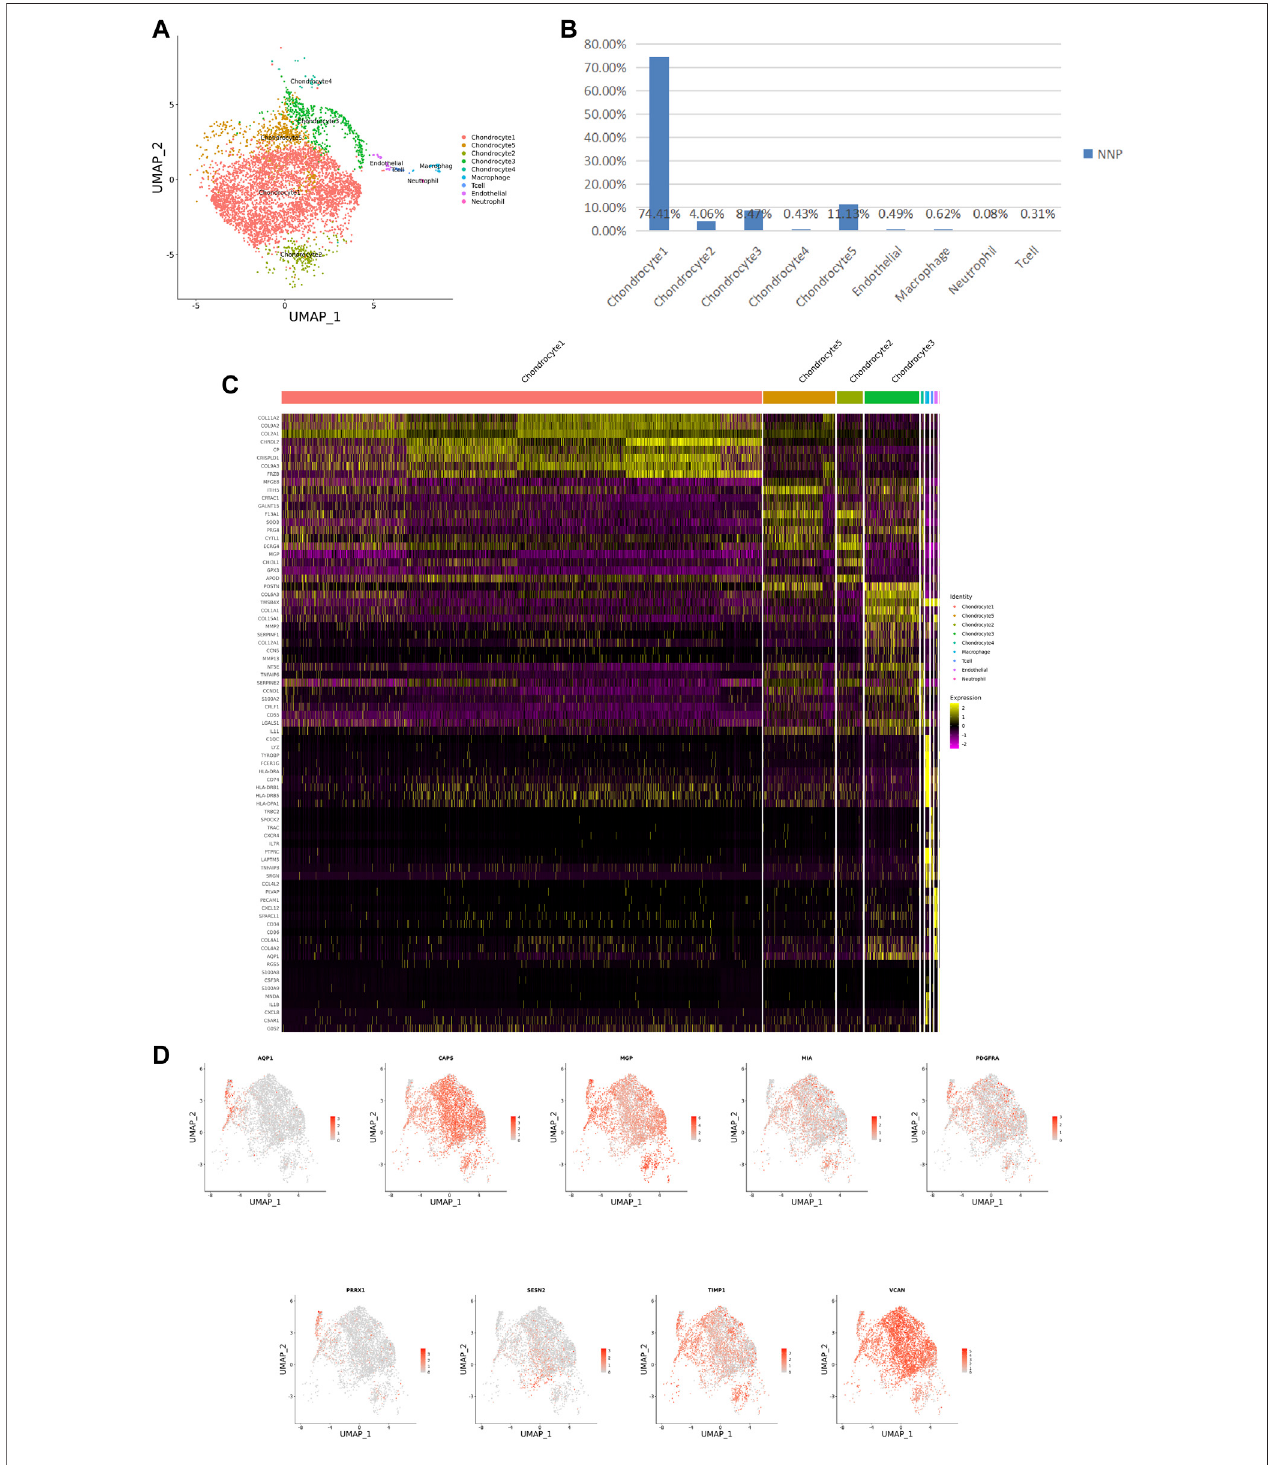
FIGURE 2 | ScRNA-seq cluster analysis of NNP cells. (A) UMAP plots of 5,147 cells, showing the nine major cell types in NNP. (B) Total number of NNP cells with stacked column chart for speci fi ed cell type. (C) Heatmap showing and highlighting differentially expressed genes for each cluster. (D) UMAP plots showing the expression of representative well-known markers for each cell type in chondrocyte (NNP).